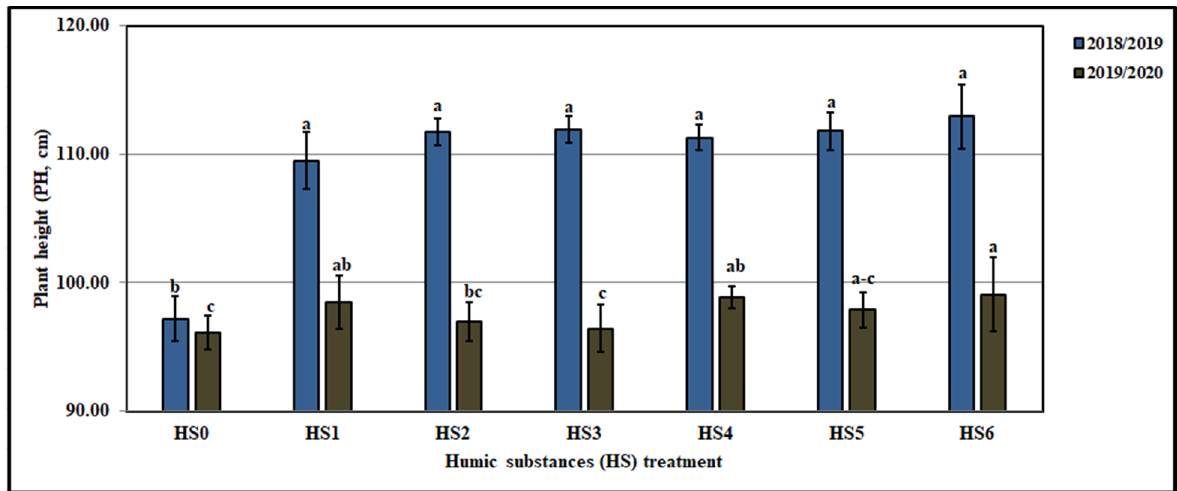
Figure 1. Influence of humic substances treatments on plant height (PH, cm) of some wheat varieties grown in clay loam soil in 2018/2019 and 2019/2020 seasons. Bars in the same years with a different letter indicate significant differences between treatments at p ≤ 0.01. HS 1, HS 2 , HS 3 represent HS applied as foliar spray at 1.0, 2.0, 4.0 g L − 1 , respectively, HS 4 , HS 5 , HS 6 represent HS applied as soil application at 5.04, 7.56, 10.08 kg ha − 1 .